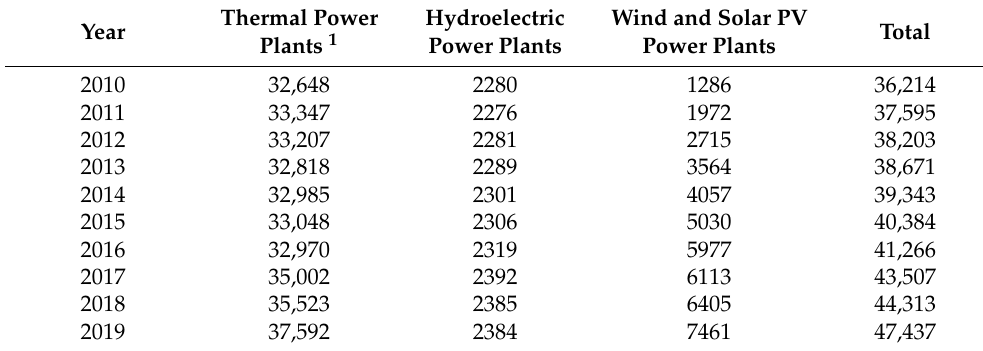
Table 3. Gross installed capacity of power plants (in